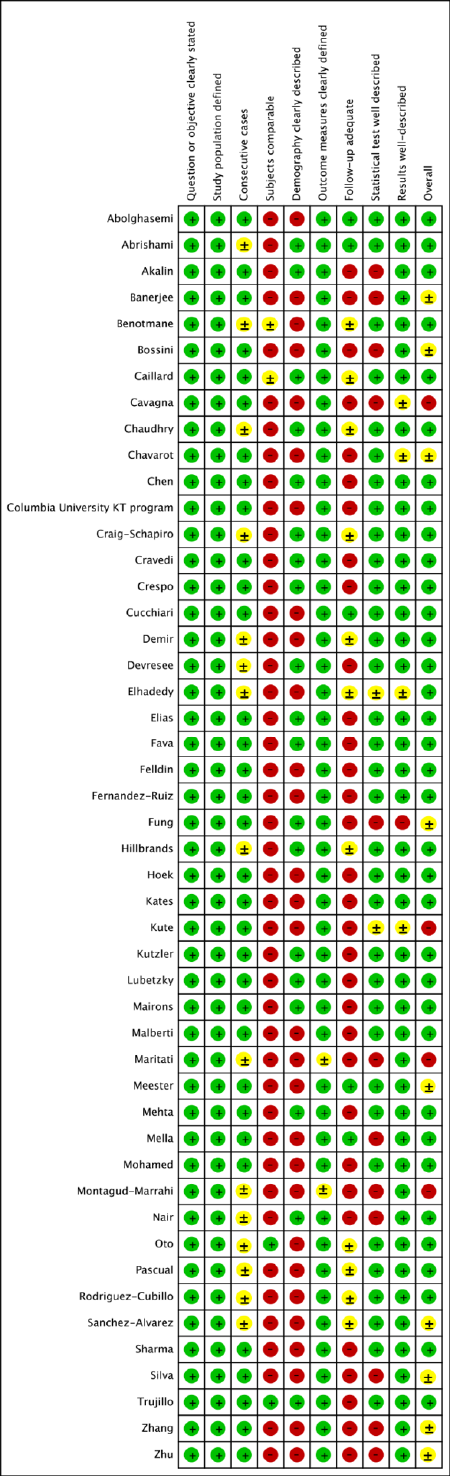
Figure 2. Quality assessment of included studies. (green-low risk of bias; yellow-unclear risk of bias; red-high risk of bias).